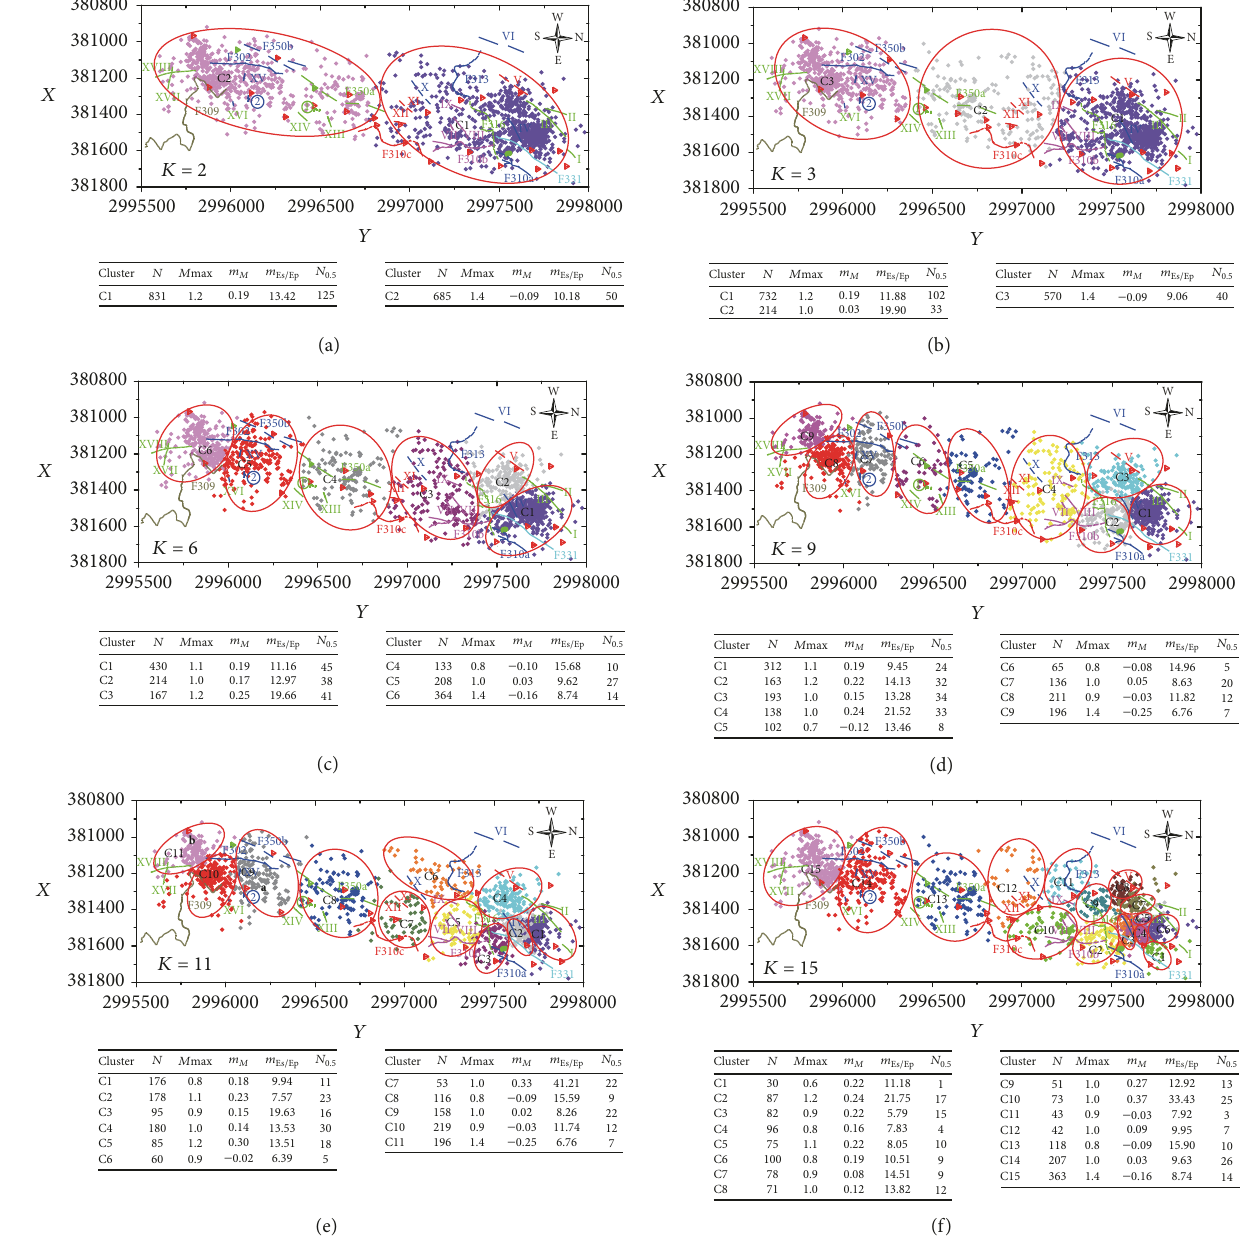
Figure 4: Cluster results and typical variables of 𝐾 -Means with different cluster numbers. (a) 𝐾 = 2 ; (b) 𝐾 = 3 ; (c) 𝐾 = 6 ; (d) 𝐾 = 9 ; (e) 𝐾 = 11 ; (f) 𝐾 = 15 . The solid lines represent determined faults, while the dashed lines represent inferred faults by mine geologists. The symbols A and B represent two caves, and the triangles represent the location of the sensors. The statistics under (a)–(f) are the typical variables for each cluster, where 𝑁 is the number of seismic events, 𝑀 max is the maximum moment magnitude, 𝑚 𝑀 is the mean moment magnitude, 𝑚 Es / Ep is the mean S-wave to P-wave energy ratio, and 𝑁 0.5 is the number of events with moment magnitude >